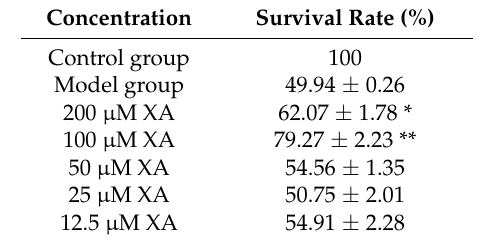
Table 3. The survival rate of XA on MPP + -injured on MN9D cells after 48 h treatment ( n = 3).